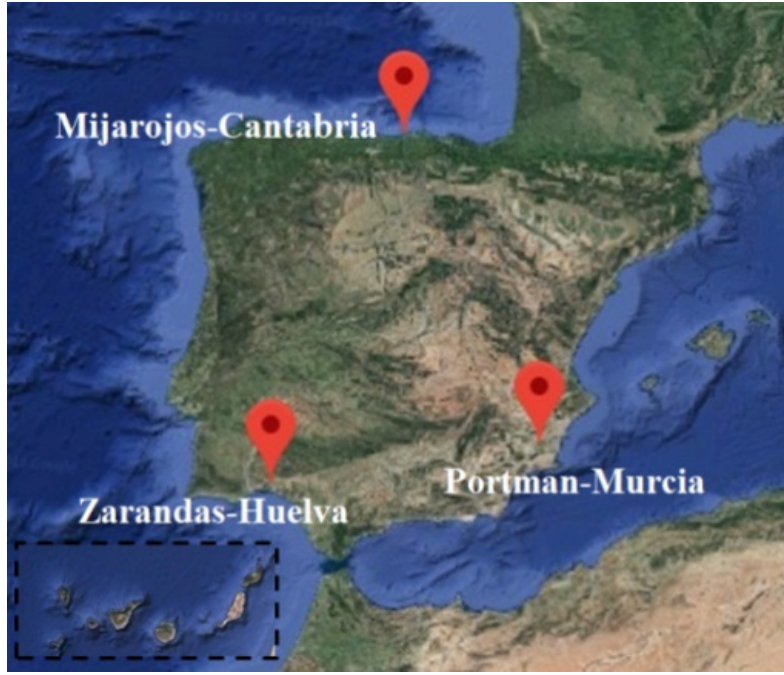
Figure 1. Map of Spain with the three selected mining areas.